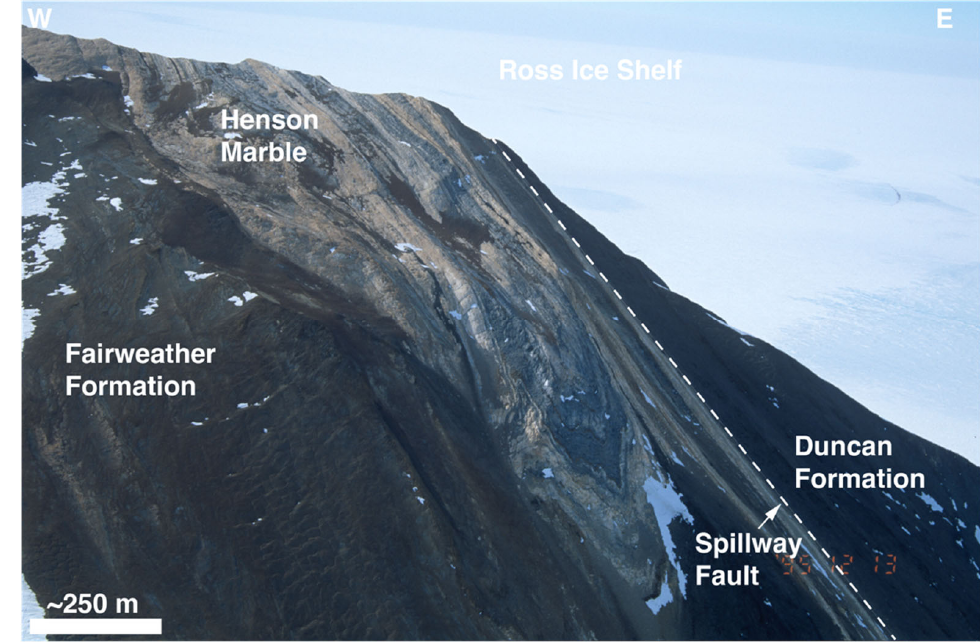
Figure 12. Photo of isoclinally folded Henson Marble Member of the Fairweather Formation in structural contact with the Duncan Formation along the Spillway Fault at Mount Henson.